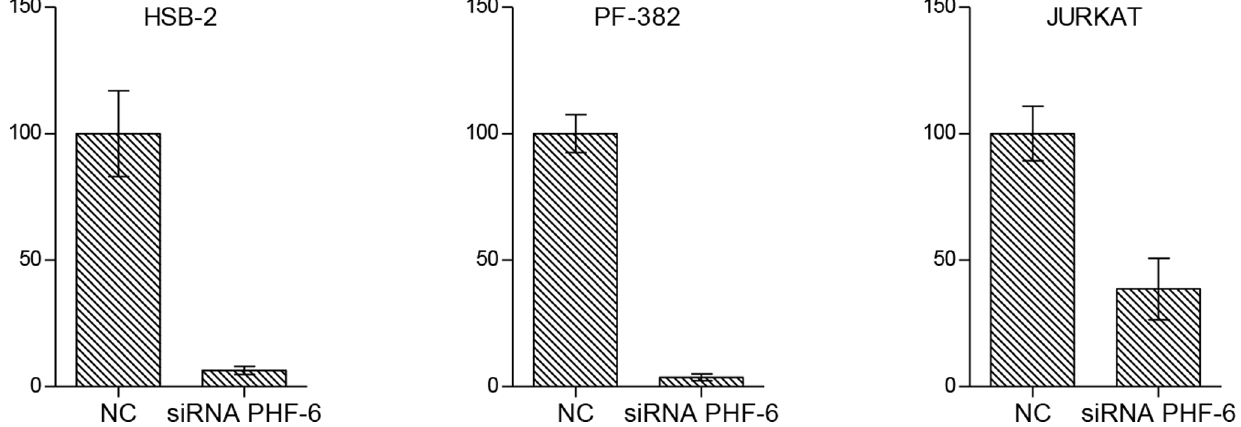
Figure 2. RT-qPCR expression data of PHF6 in T-ALL cell line. JURKAT cell line after transfection of PHF6 -targeting siRNA or scrambled siRNA (negative control: NC). Error bars, SEM